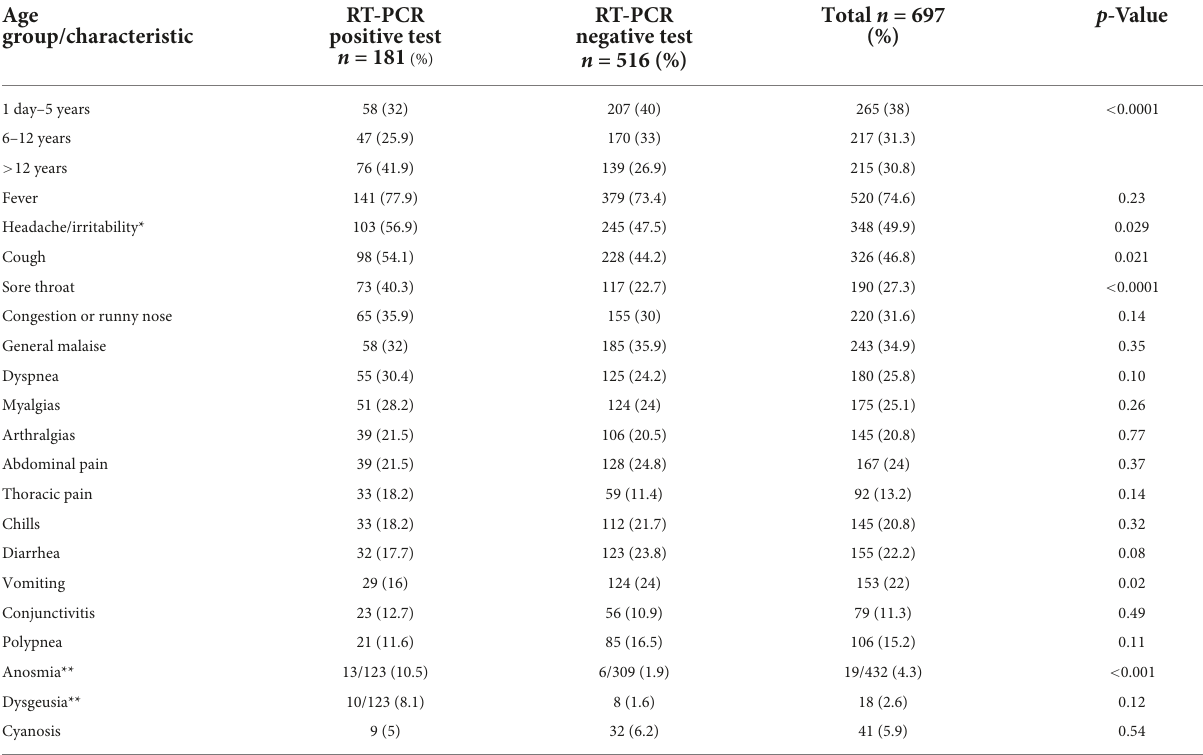
TABLE 1 Age group and clinical characteristic of patients with a positive and negative RT-PCR SARS-CoV-2 test. Age group/characteristic